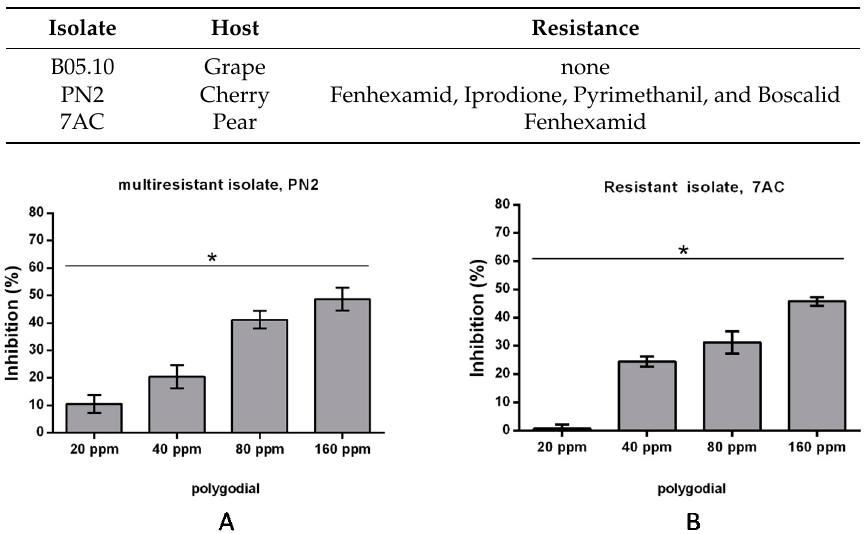
Table 1. Characteristics of Botrytis cinerea isolates used in this study.